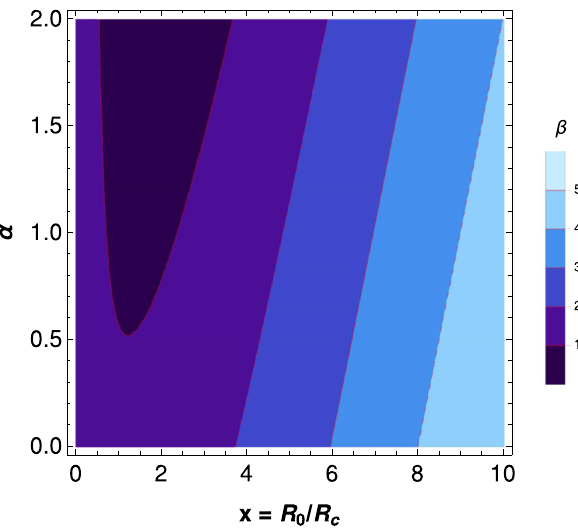
Fig. 8 β as a function of x and α . The contour shows the de Sitter solutions of the